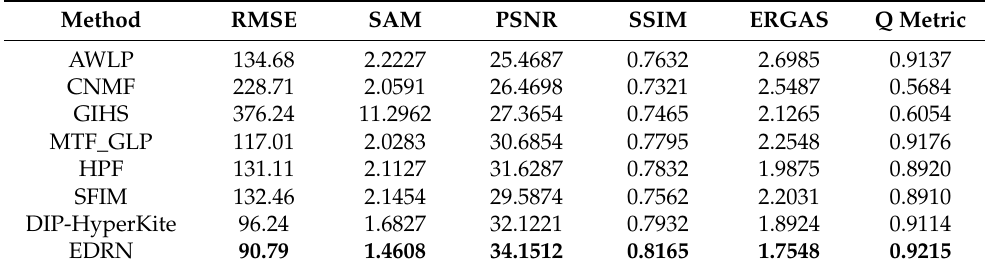
Table 5. Quality of the compared and proposed fusion methods for the Botswana dataset for RMSE, SAM, PSNR, SSIM, ERGAS and the Q